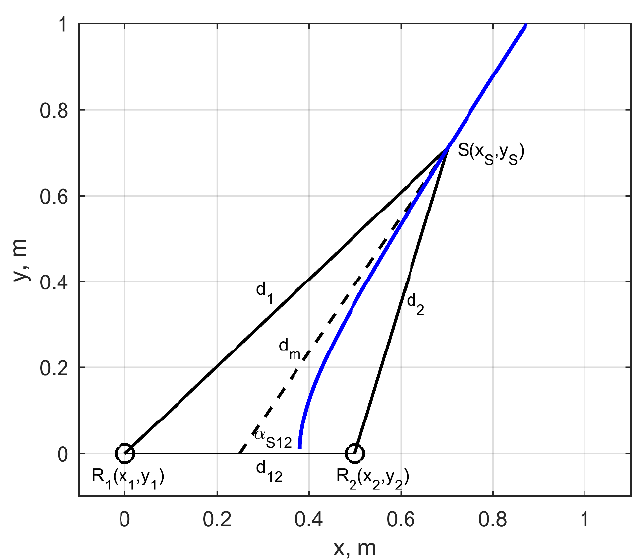
Figure 6. Graphical representation of the 2D approach when the source is located 6 m away in front and 4 m right side.